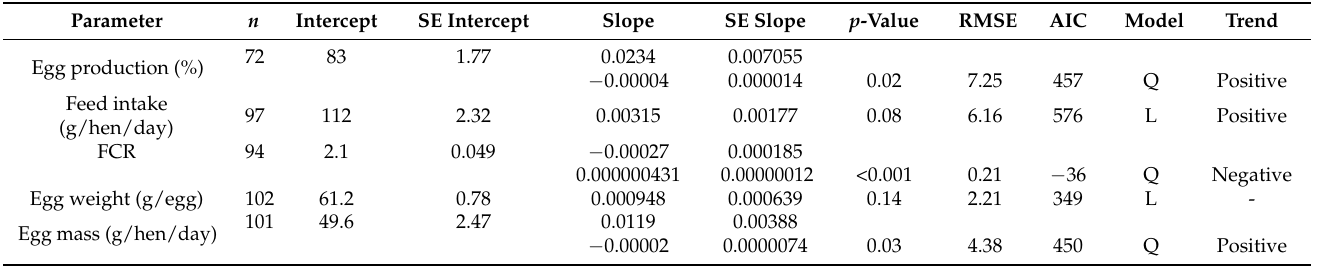
Table 2. Regression equations for the impact of phytogenic extract levels on productive performances of laying hens.